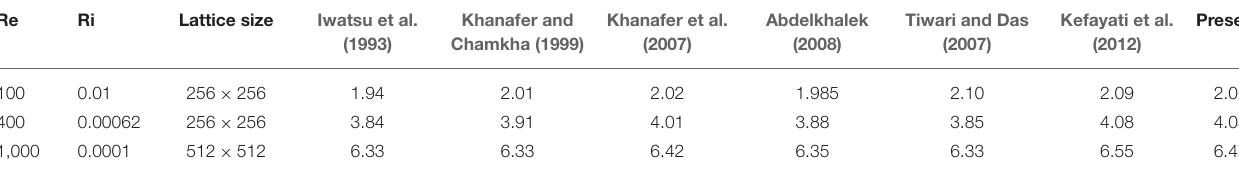
400 , Gr 100, Pr 0.71, and no porous media. = = = 100 and Pr = =